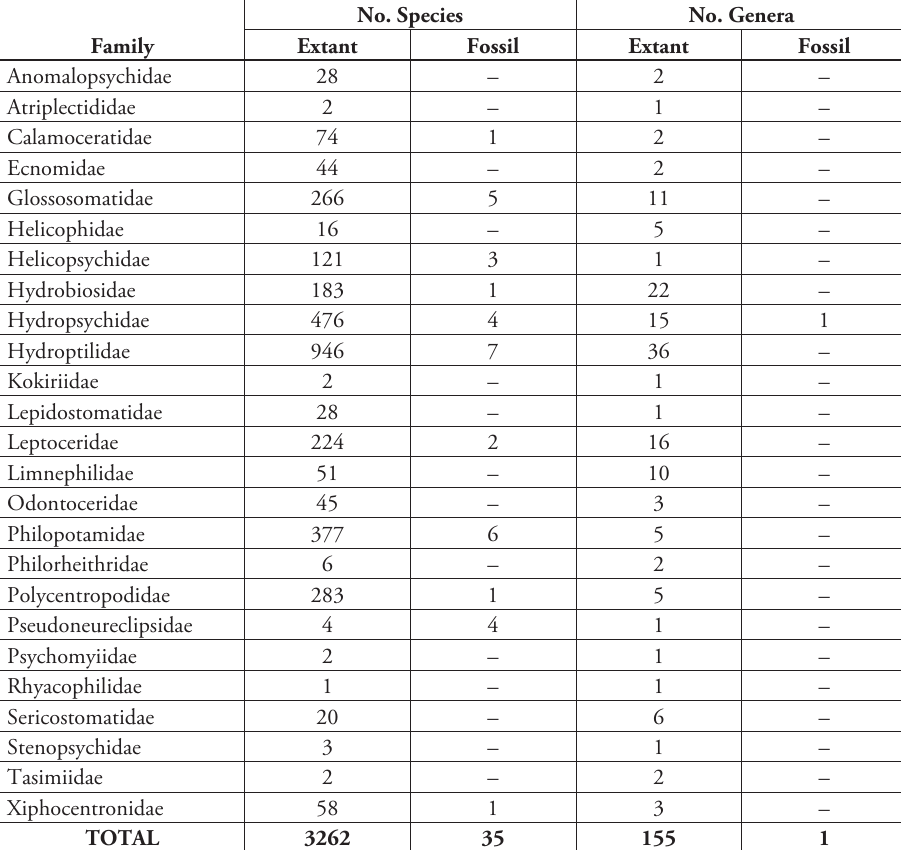
Table 1. Number of extant and fossil species and genera of Neotropical Trichoptera, by family. Family